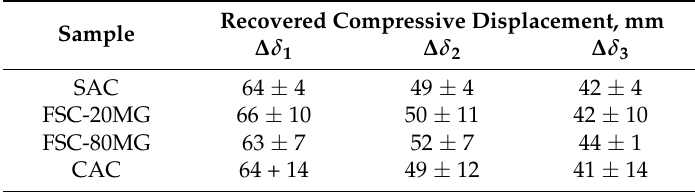
Table 3. Displacement recovery from cyclic compression test.